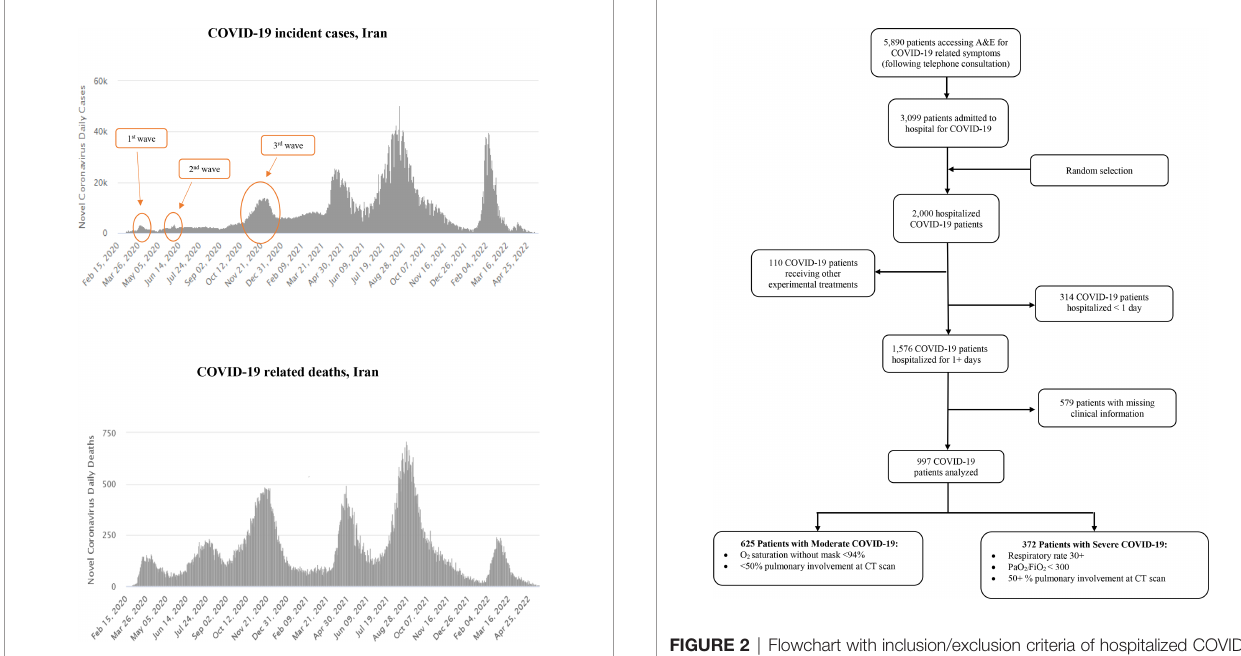
FIGURE 1 | Temporal distribution of COVID-19 incident cases (upper panel) and deaths (lower panel) in Iran, February 2020 – April 2022.